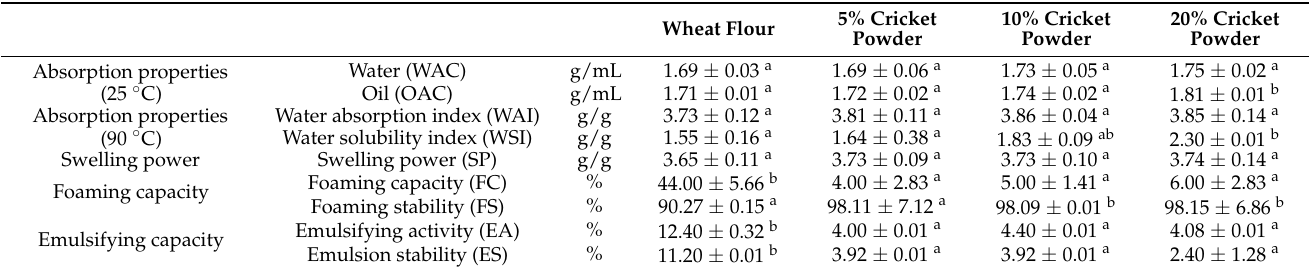
Table 1. Functional properties of wheat-cricket powder blends. Wheat